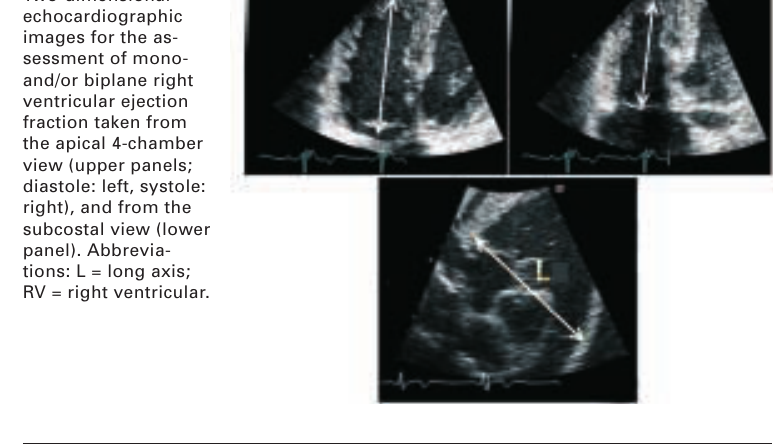
Recording of lateral tricuspid annular mo- tion velocity (TV lat ) using pulsed wave tissue Doppler imag- ing in an individual of the normal group. Systolic lateral tricus- pid annular velocity amounts to 16.5